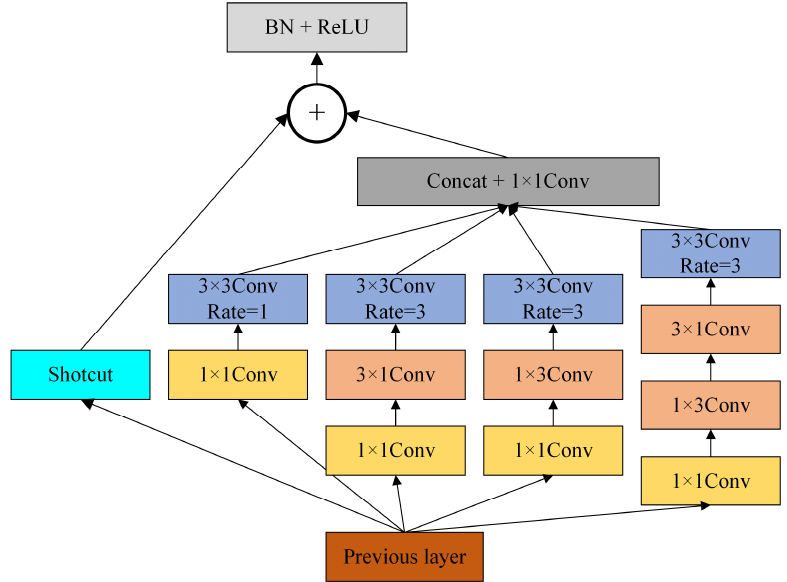
Figure 8. The structure of the improved RFB.